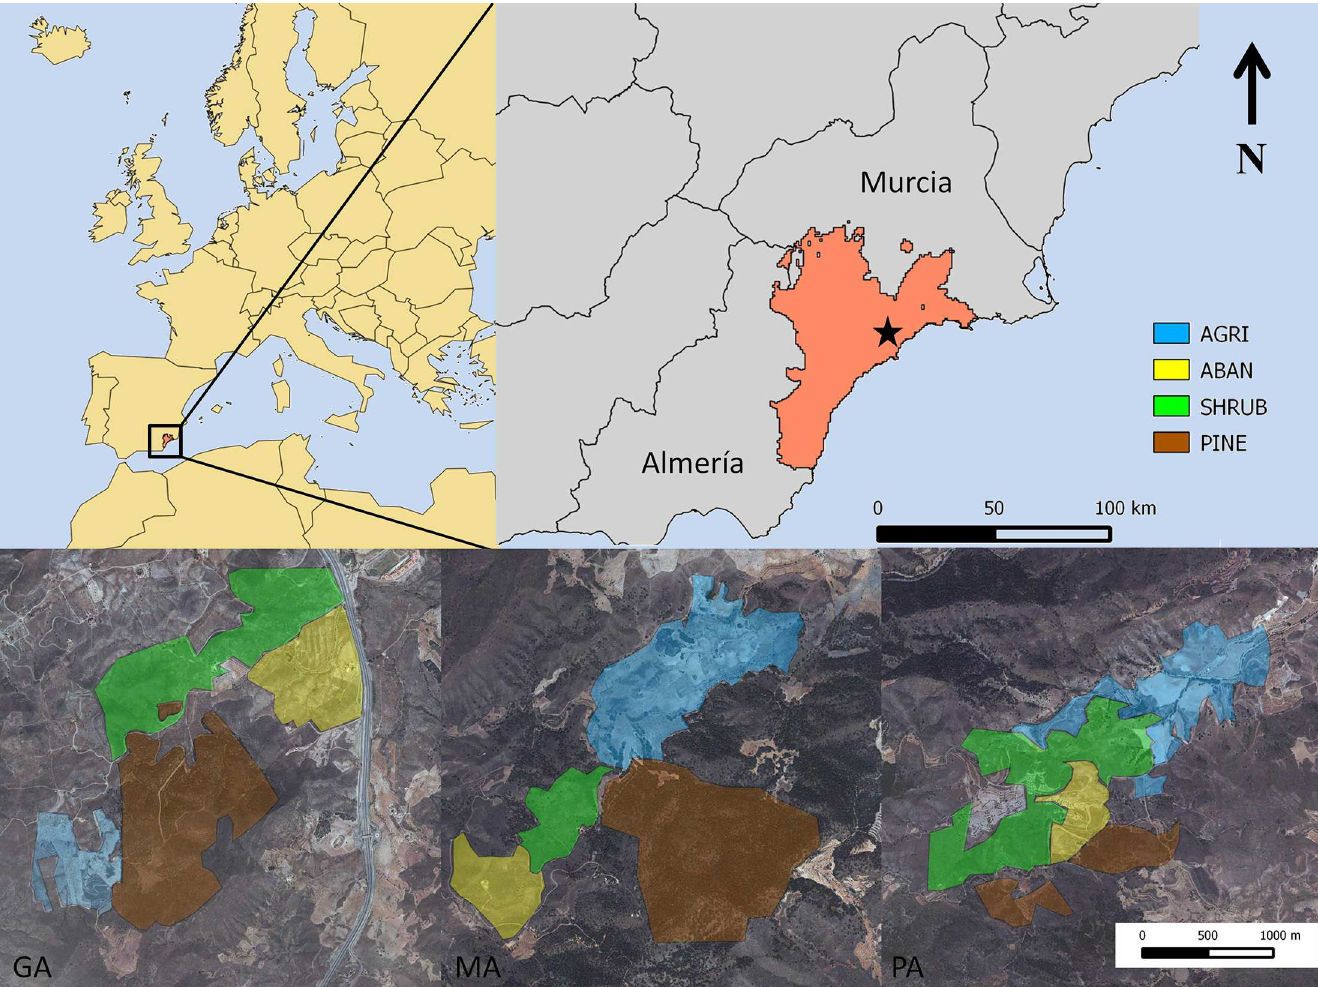
Fig 1. Location of the study sites in the southeastern Iberian Peninsula and distribution of habitat types within the field sites. The transects were performed in GA (Galera), MA (Madro ñ ales)and PA (Palomera). Down panelsare orthophotosof the PNOA (NationalAerial Orthophotography Plan) providedby the Centro Nacionalde Informacio´n Geogra´fica